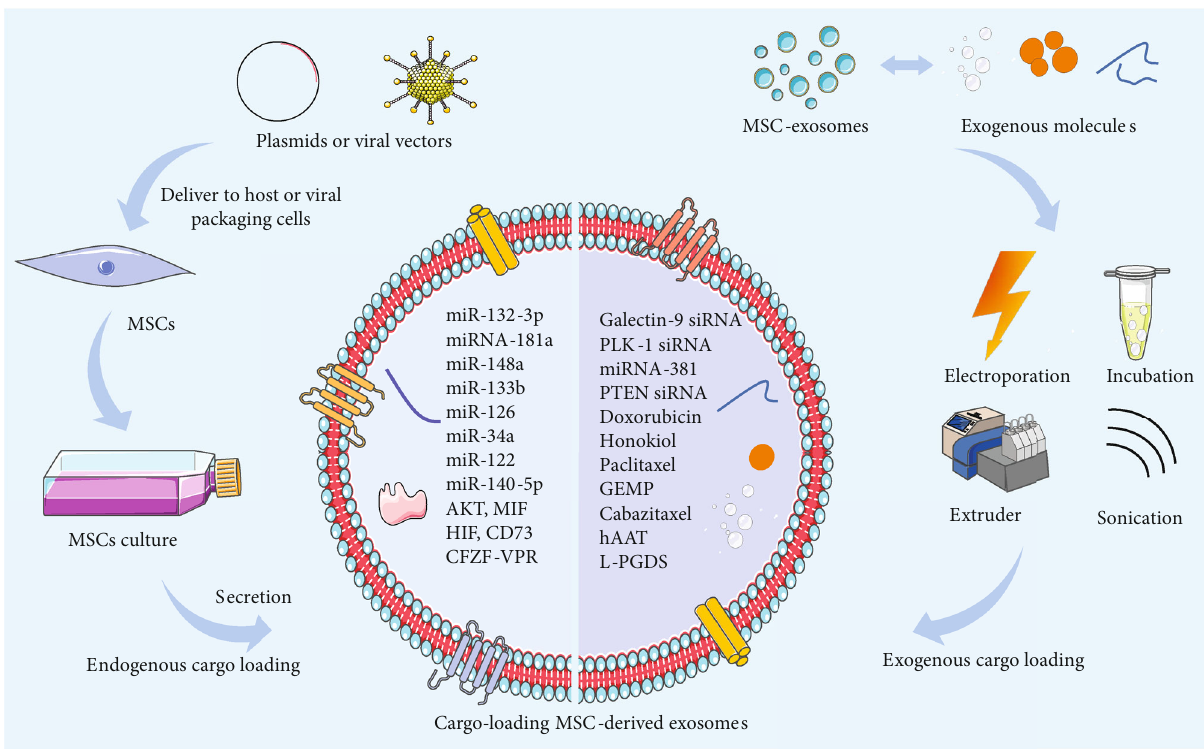
Figure 3: Cargo-loading approaches to enhance the therapeutic potential of MSC-exosomes. Endogenous cargo piggybacking is the use of plasmids or viruses to construct genetically modi fi ed parental MSC cells, followed by the collection of endogenous cargo-packed exosomes from cell culture supernatants. Endogenous cargoes are usually miRNAs and proteins with therapeutic bene fi ts. An exogenous cargo is piggybacked by the delivery of drugs or therapeutic small molecules into exosomes using methods such as electroporation, coincubation, or